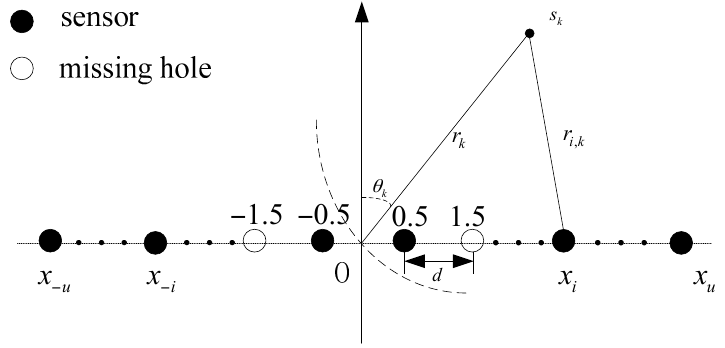
Figure 1. Non-uniform linear array configuration (The number of sensors is assumed to be even).